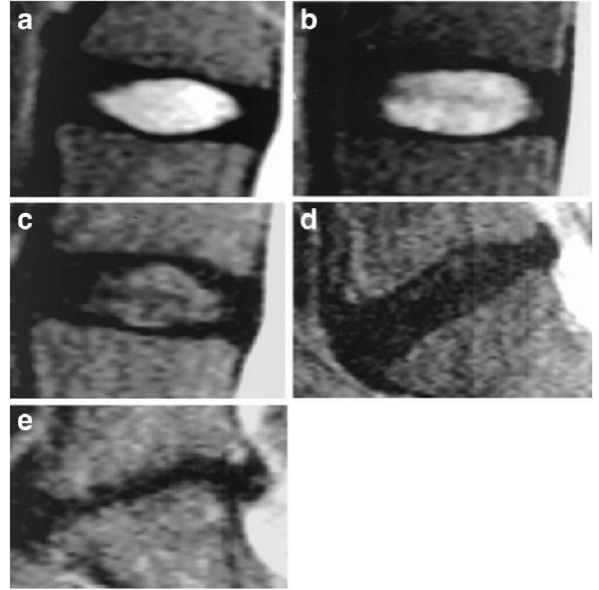
Figure 1. Pfirrmann classification (reused from [34]). A qualitative visual assessment method for lumbar disc degeneration using T2-weighted mid-sagittal images. Images represent the five Pfirrmann grades ranging from grade I ( a ) to V ( e ), representing healthy to severely degenerated IVD respectively. ( a ) Grade I: The structure of the disc is homogeneous with a bright white signal intensity and a normal disc height. ( b ) Grade II: The structure of the disc is not fully homogeneous with a clear boundary between nucleus pulposus (NP) and annulus fibrosus (AF), and a normal disc height. ( c ) Grade III: The structure of the disc is inhomogeneous with a moderately decreased white signal intensity, an unclear boundary between NP and AF, and an almost normal disc height. ( d ) Grade IV: NP signal intensity is darkened with no boundary between NP and AF, and a moderately decreased disc height. ( e ) Grade V: NP signal intensity is black with collapsed disc space.